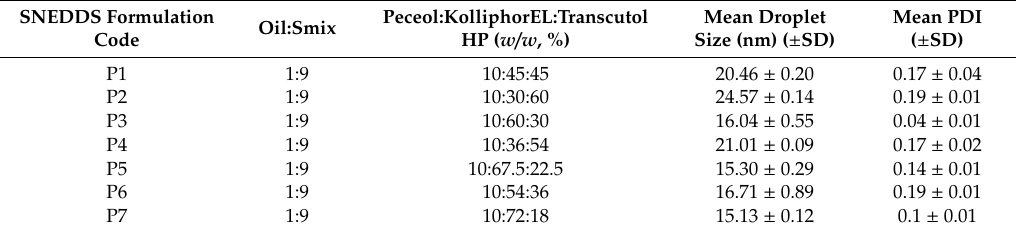
Table 1. Droplet size and Polydispersity index (PDI) values of self-nanoemulsifying drug delivery system (SNEDDS) combinations for emulsification e ffi cient ( n =